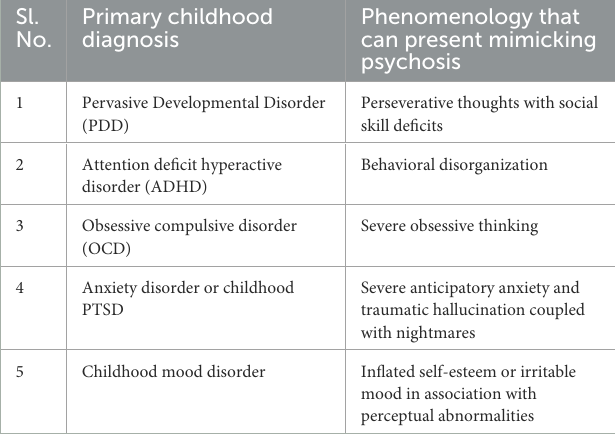
TABLE 1 Phenomenology in other childhood diagnosis mimicking psychosis. Sl.